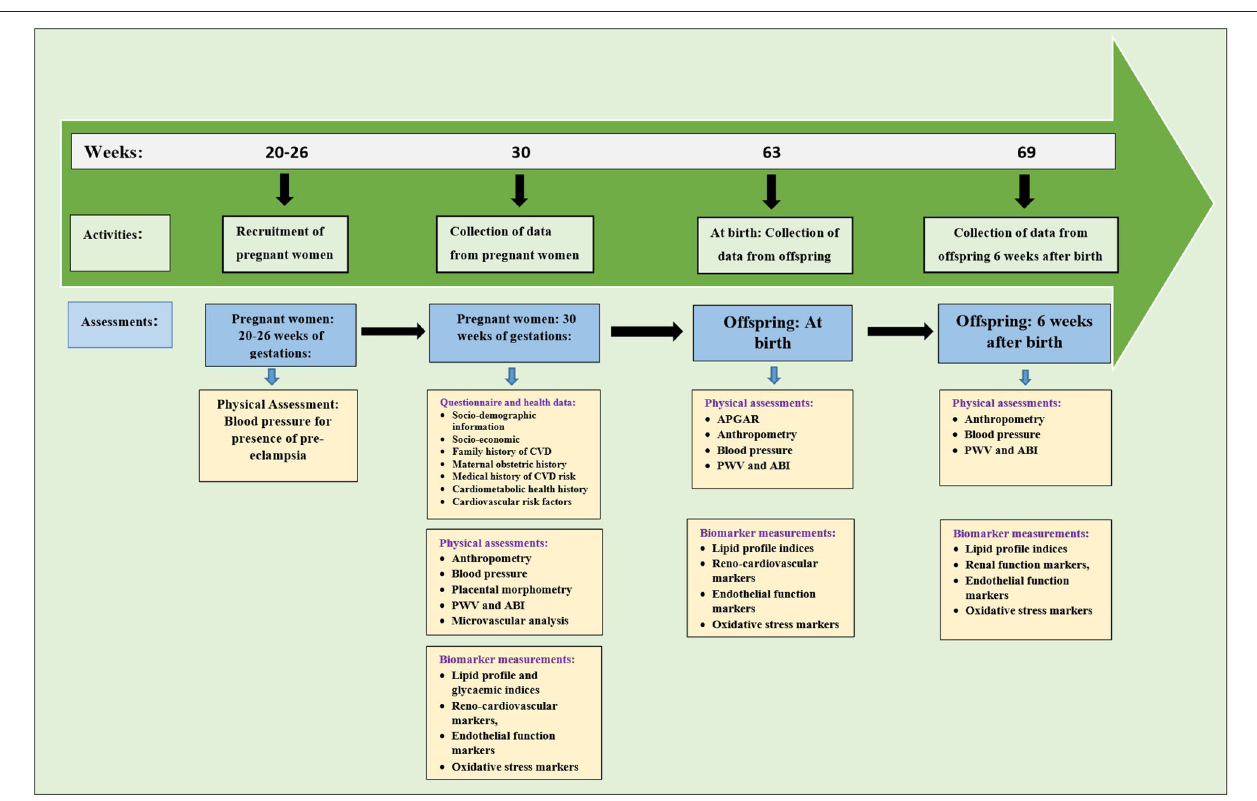
FIGURE 2 | Timeline of the study along with physical and biomarkers